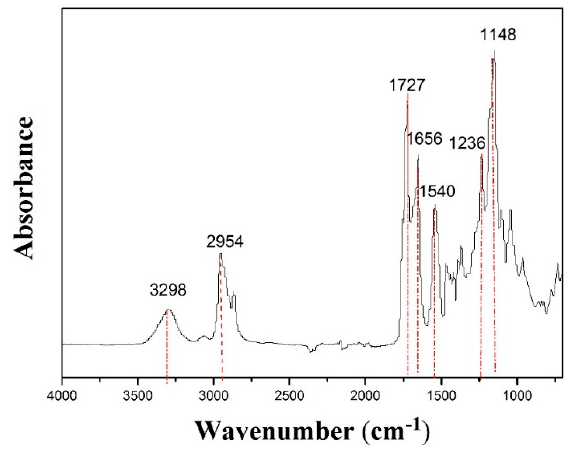
Figure 2. ATR-FTIR of electrospun PCL-PIBMD fibrous meshes.